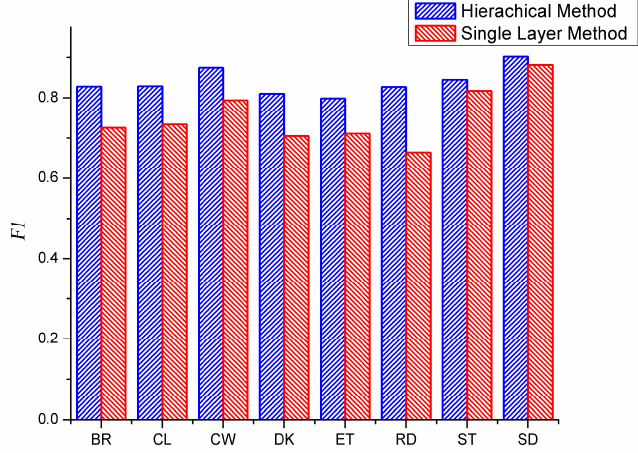
Figure 11. Comparison between the hierarchical method and single layer method.